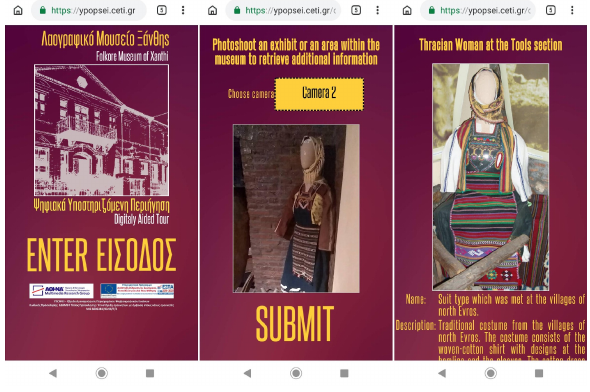
Figure 4. Screenshots from the experimental Web application performing a query-by-example and receiving relevant digital content to a captured exhibit.